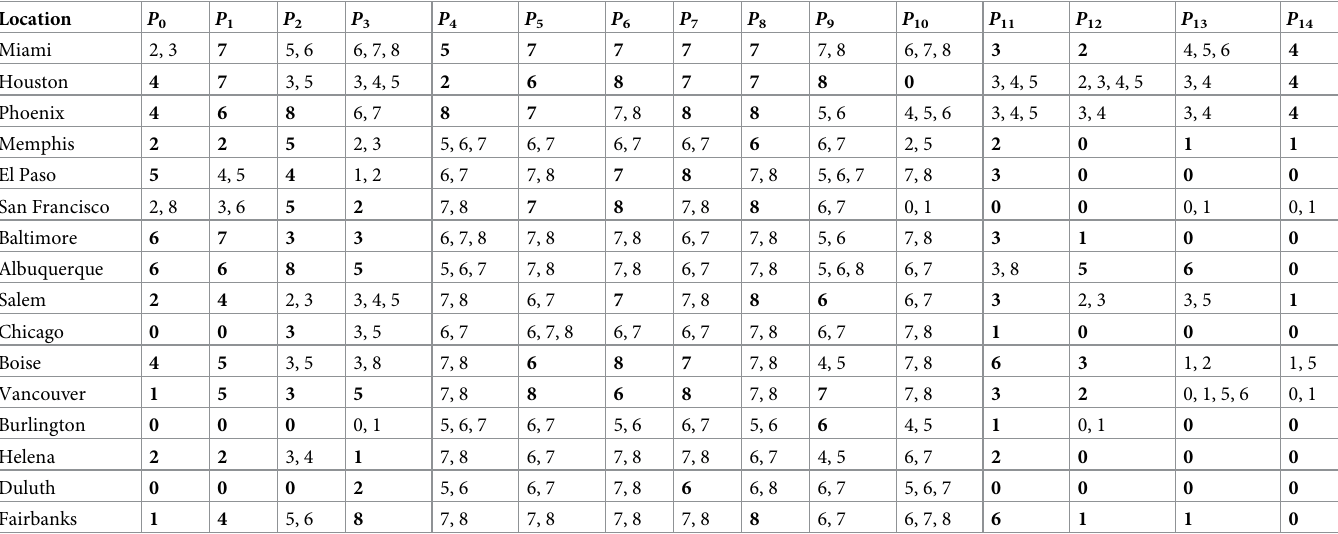
Table 3. Neighborhoods used in local search to improve the best solution found by genetic algorithm.